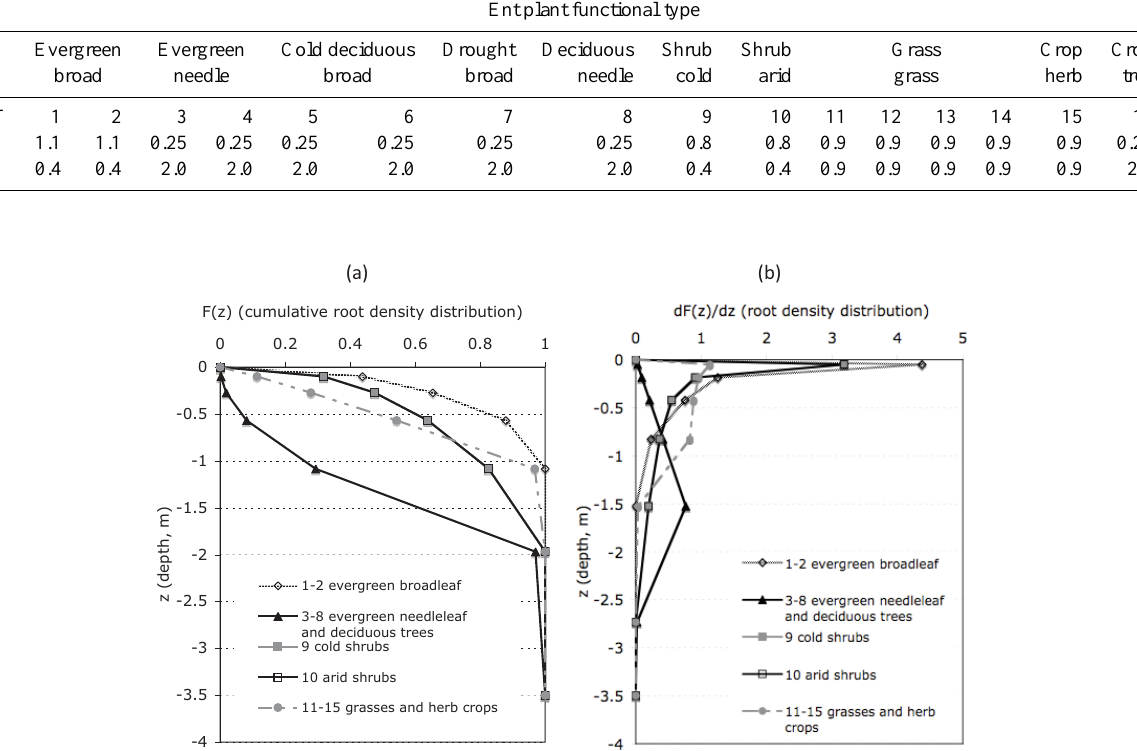
Figure A1. (a) Cumulative root density profile distributions and (b) probability density distributions in the Ent TBM (modified from Rosen- zweig and Abramopoulos, 1997) vs. soil depth increments of the NASA GISS GCM land surface